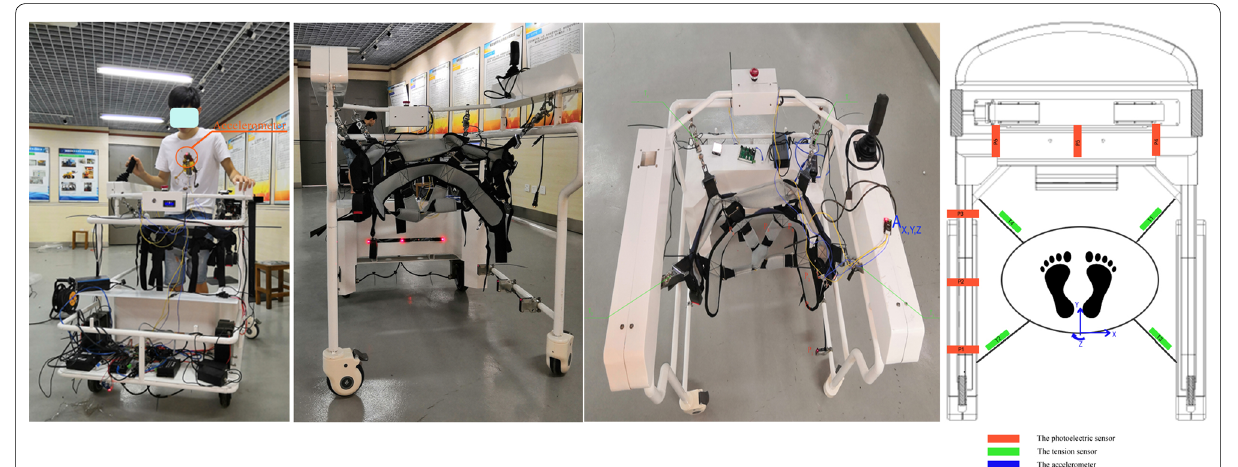
Figure 3 The tri-sensor detection